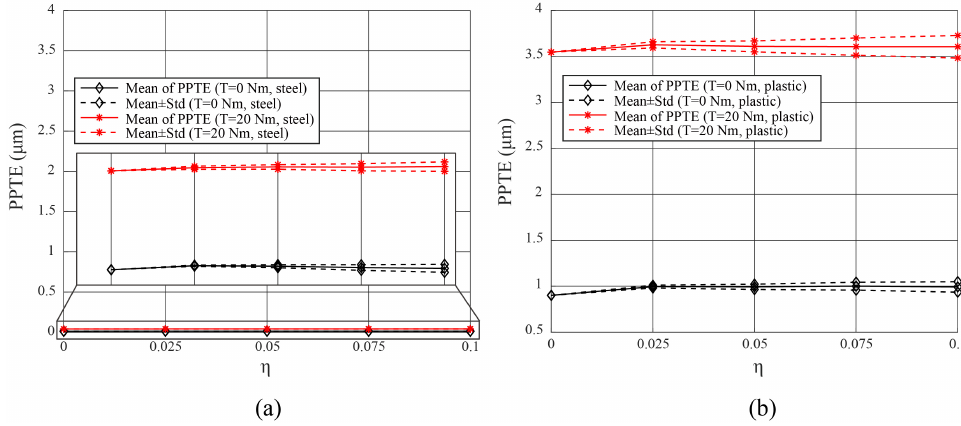
Figure 15. Peak-to-peak transmission error of ( a ) steel and ( b ) plastic spur gear pairs with regard to change in η . There is no machining error or pitch error ( (cid:101) = 0, e p = 0 )